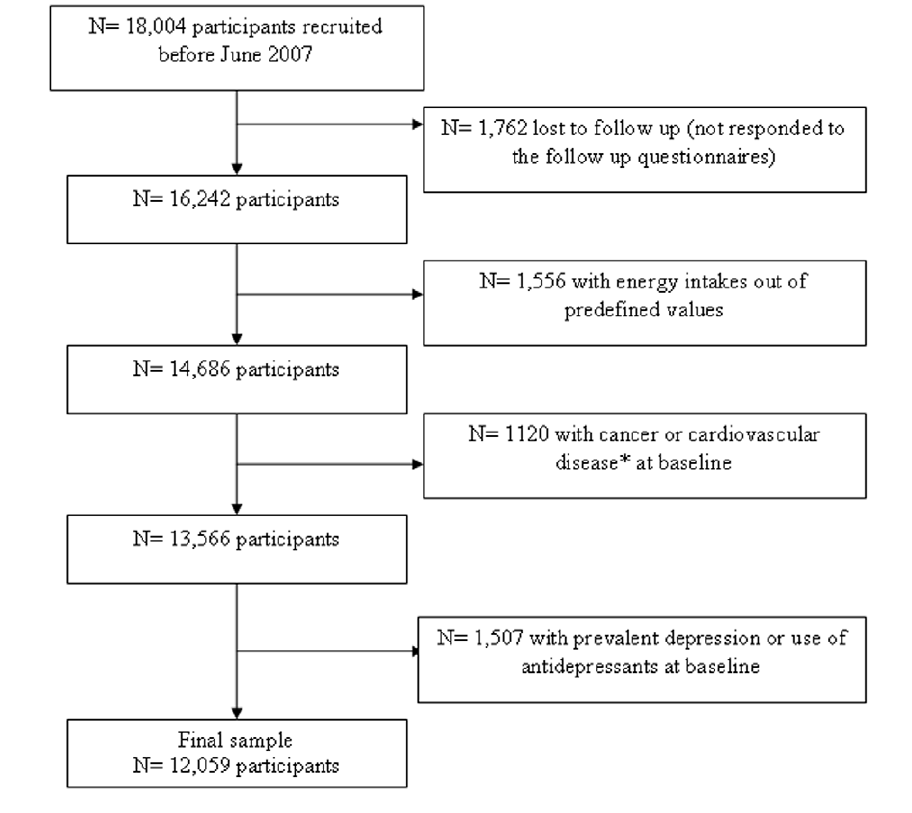
Figure 1. Flow chart of participants. The SUN Project.